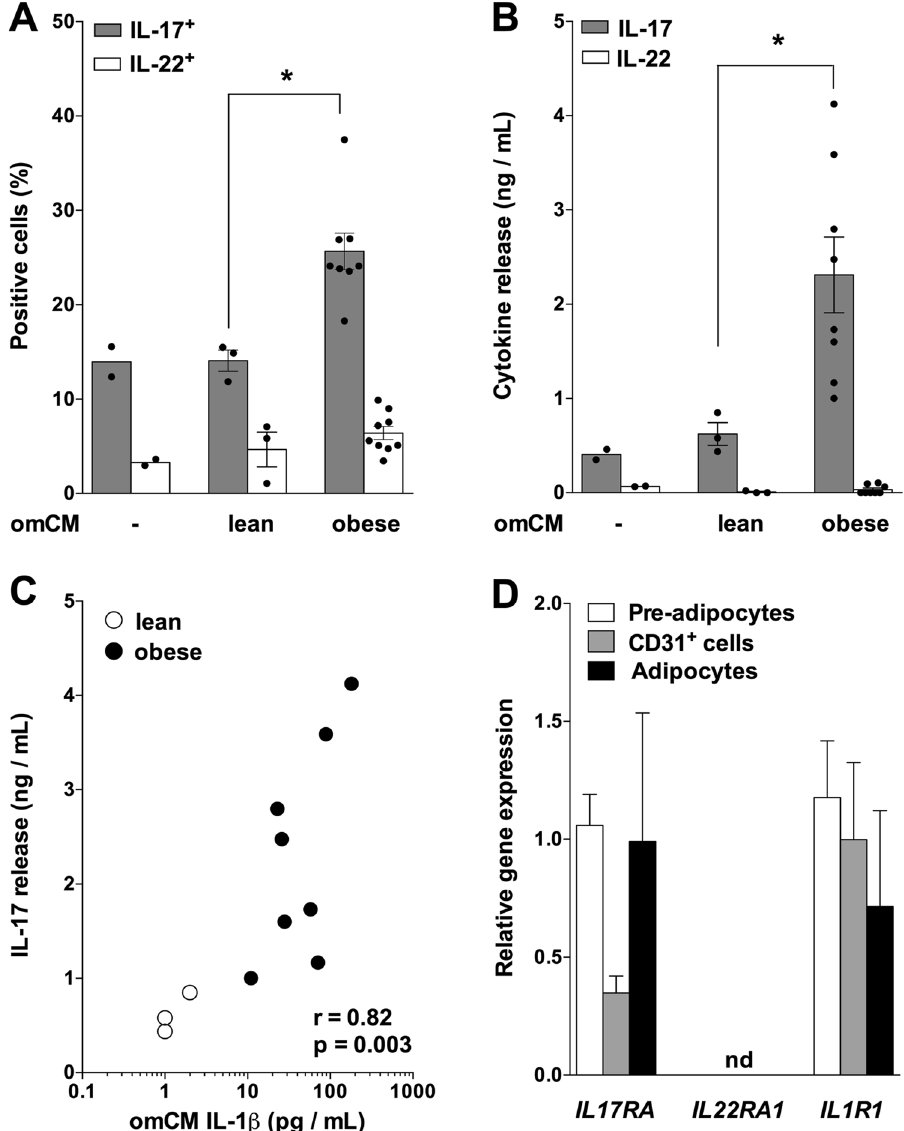
Figure 1. Obese omental adipose tissue microenvironment promotes IL-17 release. ( A ) IL-17 + and IL-22 + cells were quantified by FACS analysis of blood-derived memory CD4 + T cells cultured for 7 days without or with conditioned medium of omental adipose tissue (omCM) from lean (n = 3) or obese (n = 8) subjects. * P < 0.05. ( B ) IL-17 and IL-22 concentrations were determined by Luminex in blood-derived memory CD4 + T cells culture medium. * P < 0.05. ( C ) Correlation analysis between IL-17 concentration in blood CD4 + T cells culture medium and IL-1 β concentration in omCM. The correlation coefficient (r) and p value were obtained by Spearman’s test. (D) IL17RA, IL22RA1 and IL1R1 mRNA were determined in pre-adipocytes (n = 7), CD31 + endothelial cells (n = 6) and adipocytes (n = 4) obtained from lipoaspirate adipose tissue samples. Data are shown as mean ± SEM. nd: not